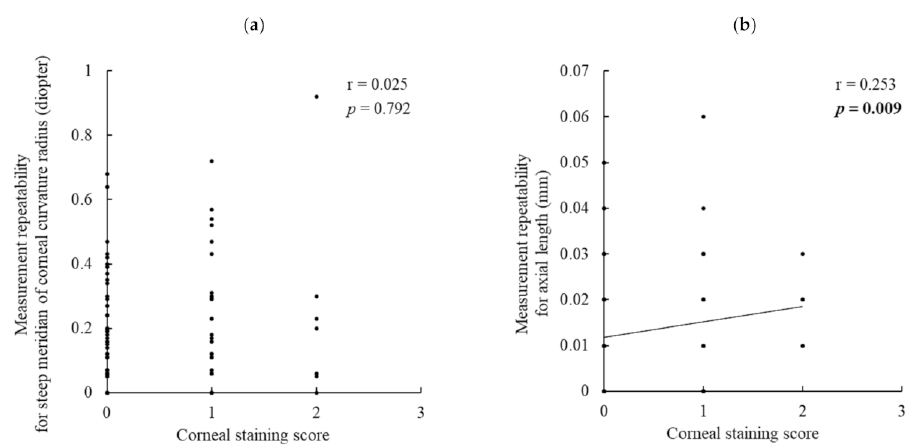
Figure 2. Correlations between the corneal staining score and measurement reproducibility of the steep meridian of corneal curvature radius and axial length: ( a ) steep meridian of corneal curvature radius and ( b ) axial length. The corneal staining score was significantly correlated with the measurement repeatability of axial length but not with that of the steep meridian of corneal curvature radius. Boldface values indicate statistical significance. Correlation was evaluated using Spearman’s correlation analysis.